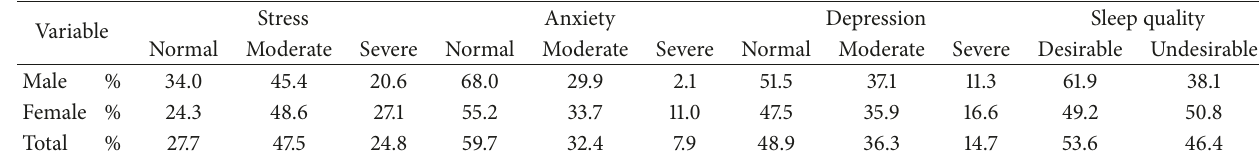
Table 1: Prevalence of stress, anxiety, and depression based on gender.